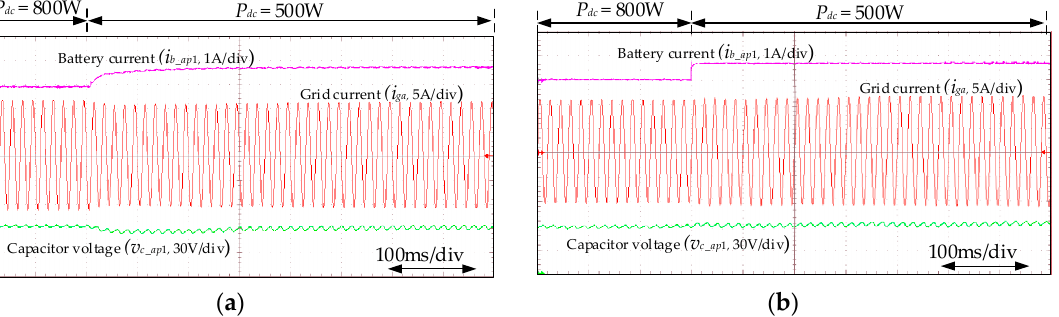
Figure 18. Experimental waveforms of dynamic performance of the MMC-BESS. ( a ) Without the proposed control strategy. ( b ) With the proposed control strategy.